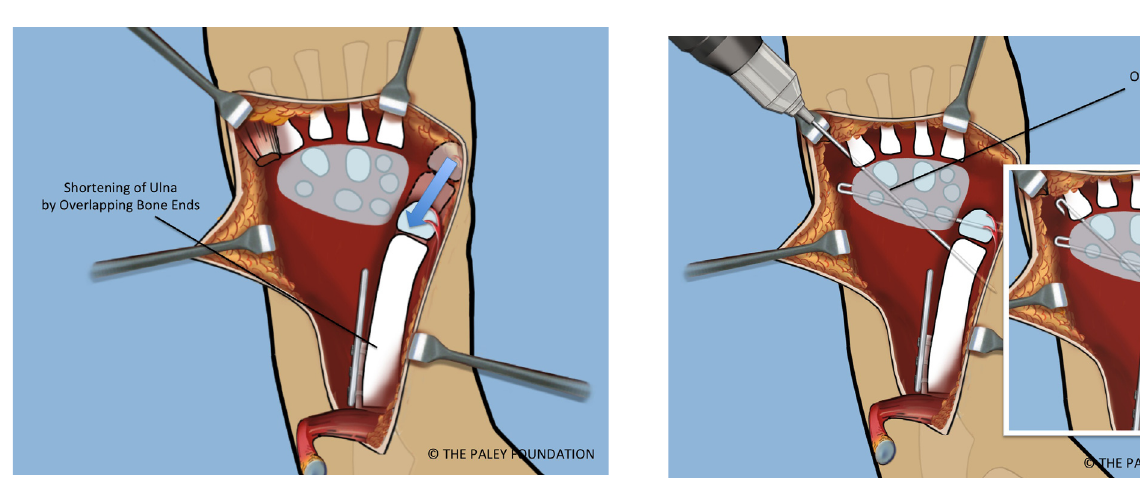
Figure 18. A second retrograde oblique wire is inserted from the fifth metatarsal base to the distal ulnar metaphysis. These wires should be cut and curled 180 (cid:3)